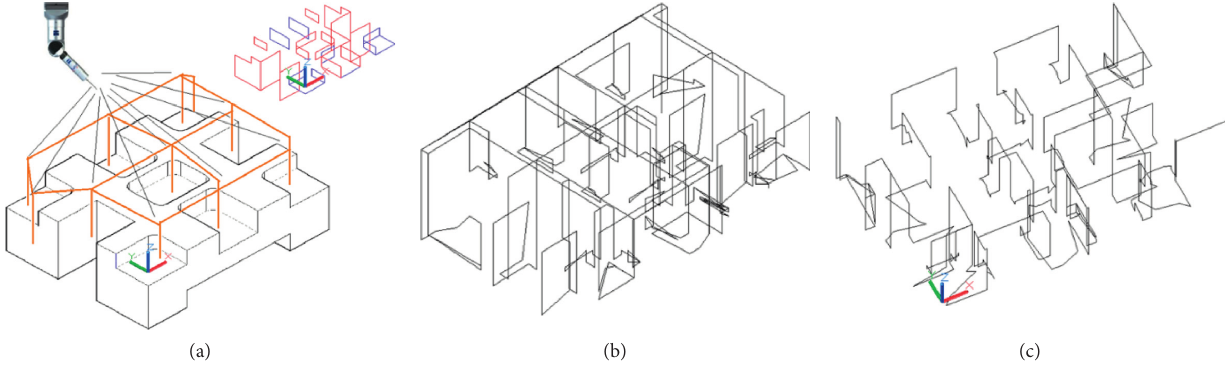
Figure 9: (a) Measured part; (b) measurement path before GA; (c) measurement path after GA.